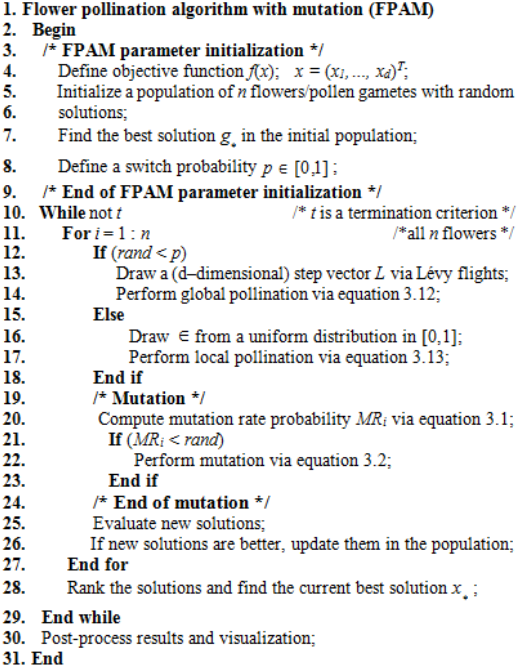
Figure 5: The general pseudo–code for